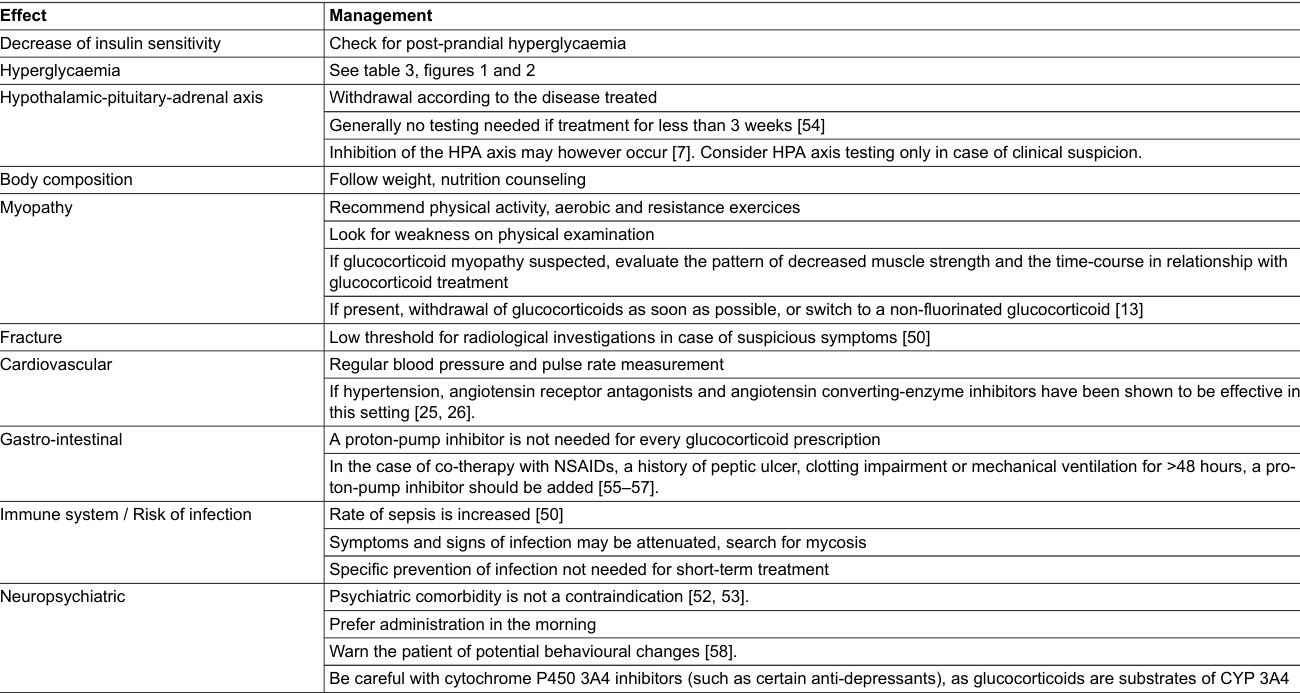
Table 2: Check-list of reported glucocorticoid short-term side effects and their